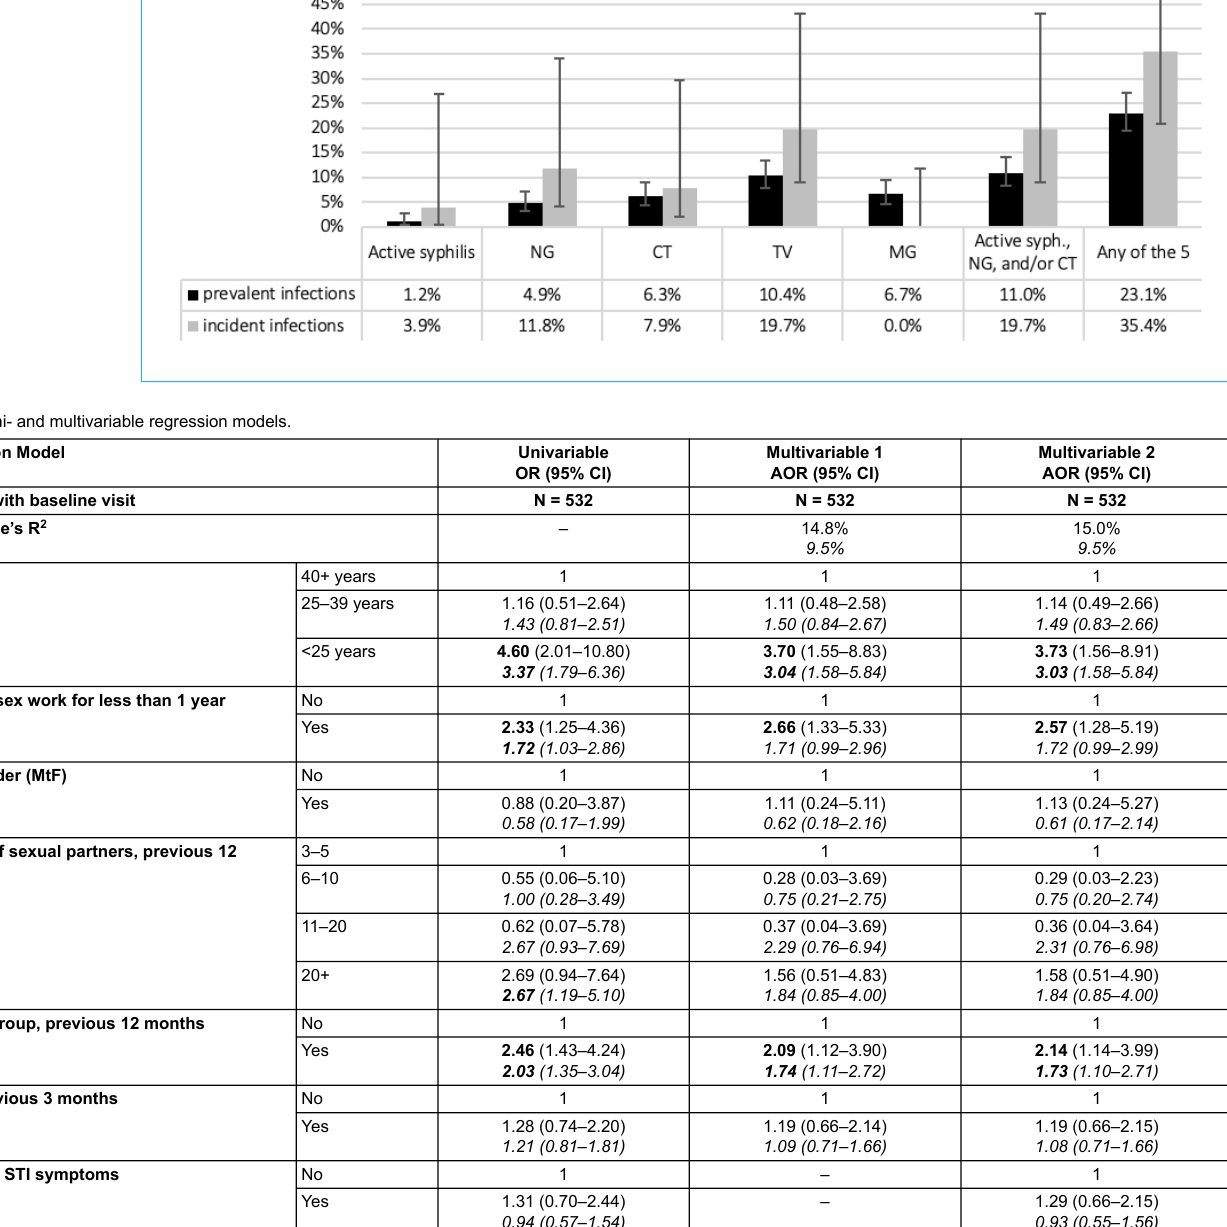
Figure 1: Sexually transmitted infections among female sex workers at baseline (n = 490) and during follow-up (n = 42 over 46 follow-up vis- its; 25.4 years of follow-up); percent with 95% confidence interval. CT = C. trachomatis ; MG = M. genitalium ; NG = N. gonorrhoeae ; TV = T. vaginalis .